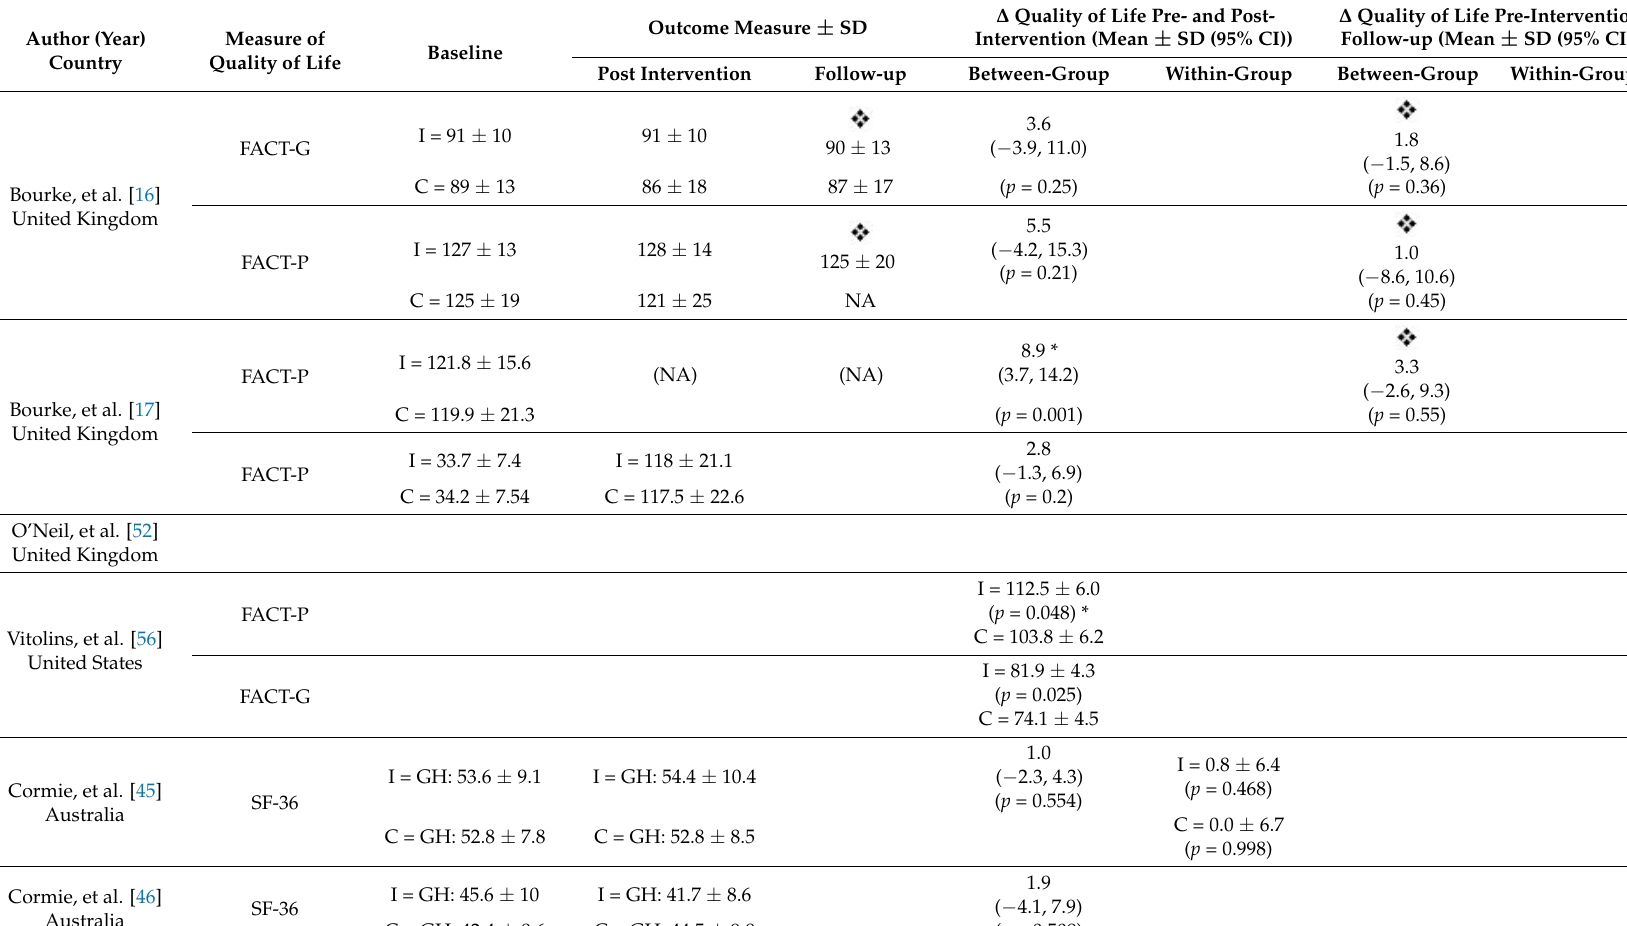
Table 5. Quality of life outcome